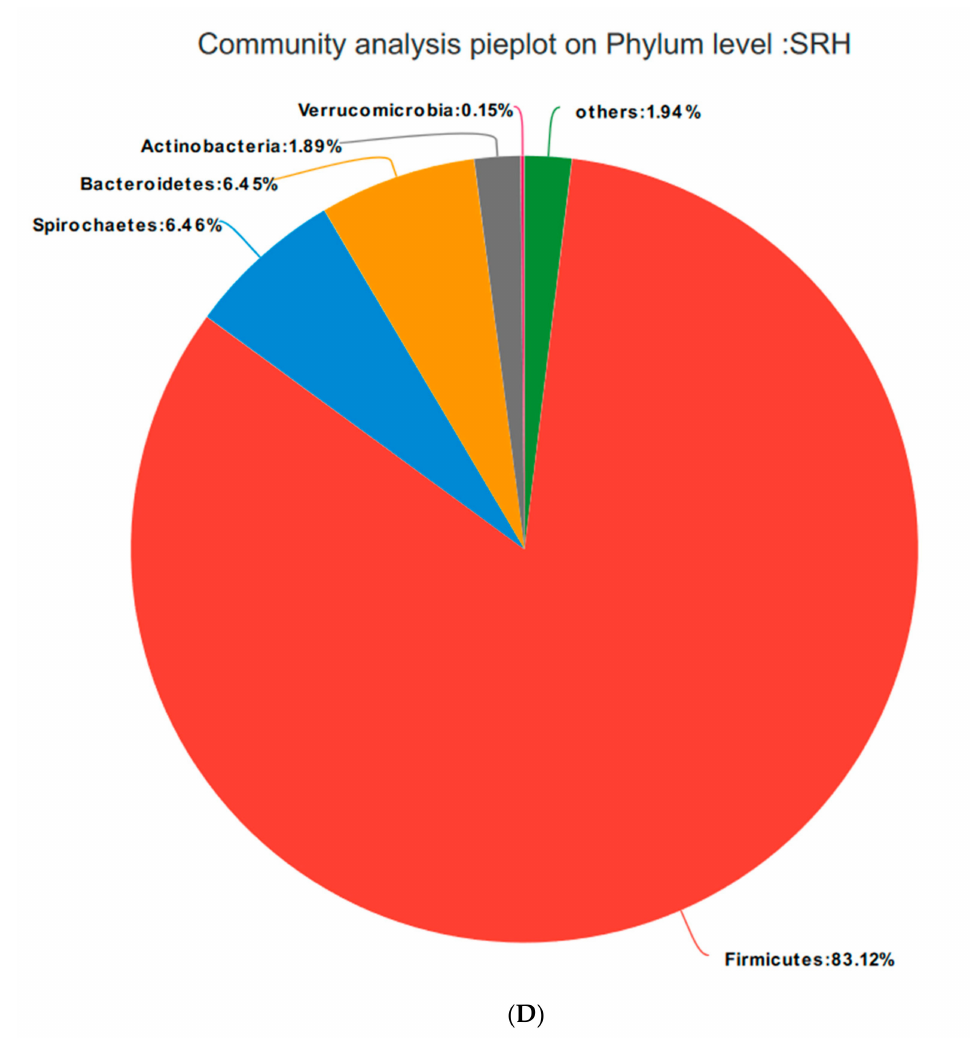
Figure 7. Fan chart of the relative phyla abundances. The gut bacterial composition at the phylum level in each sample. According to the results of the species notes, we selected the gut bacterial species at the phylum level in CON ( A ), SRL ( B ), SRM ( C ), and SRH ( D ). Relative abundances < 0.01% were classified as